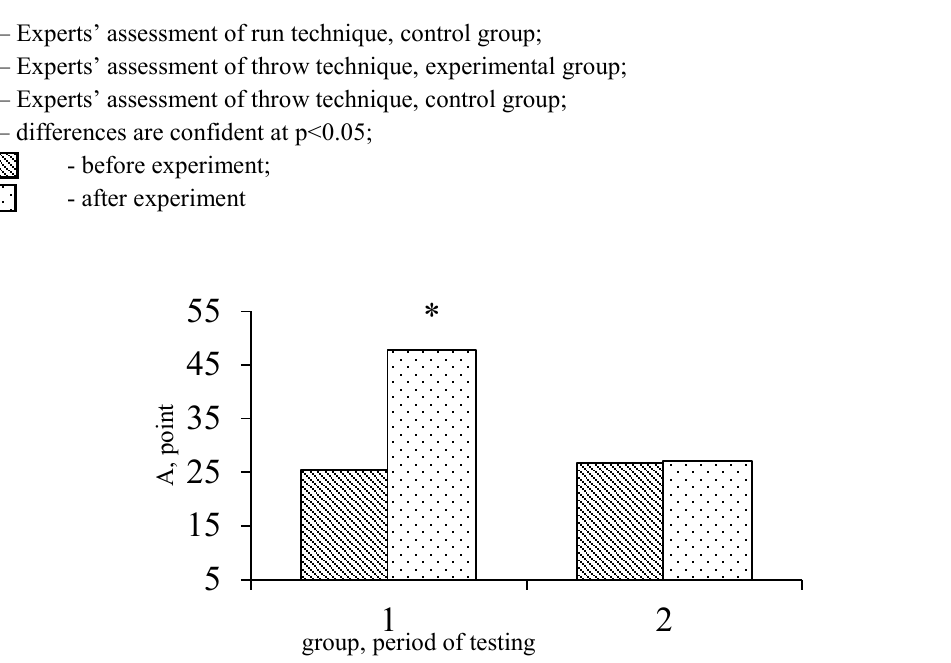
Fig. 4. Level of theoretical knowledge on light athletic of experimental (n=21)and control (n=22) groups’ pupils before and after experiment